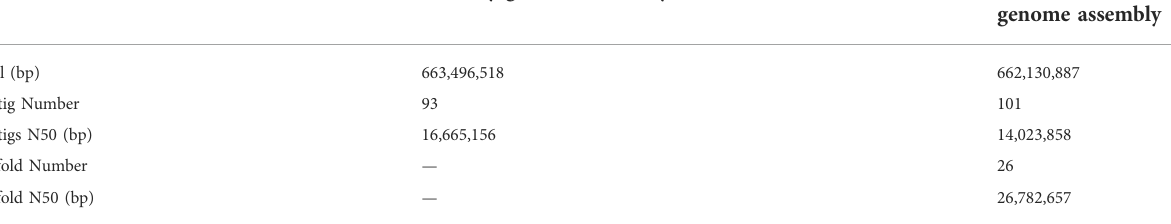
TABLE 2 Statistics of the P. vachelli genome before and after chromosome level assembly.